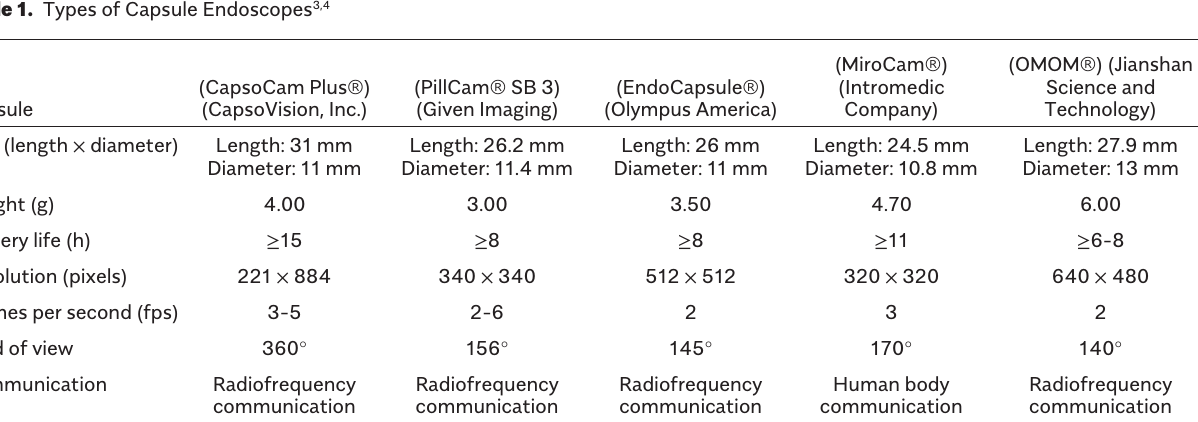
Table 1. Types of Capsule Endoscopes 3,4